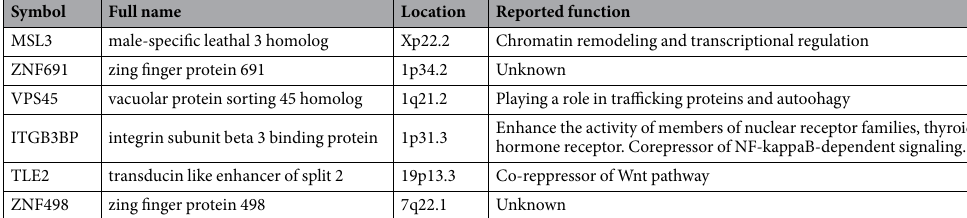
Table 1. Gene lists detected by functional genomics